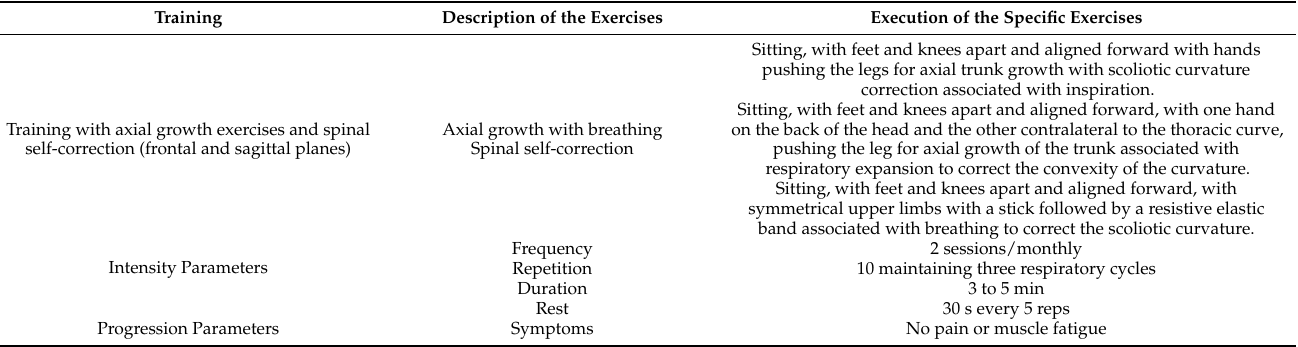
Table 1. Intervention protocol with specific exercises for axial growth and spinal self-correction (frontal and sagittal planes) for adolescents with idiopathic scoliosis (AIS). Training Description of the